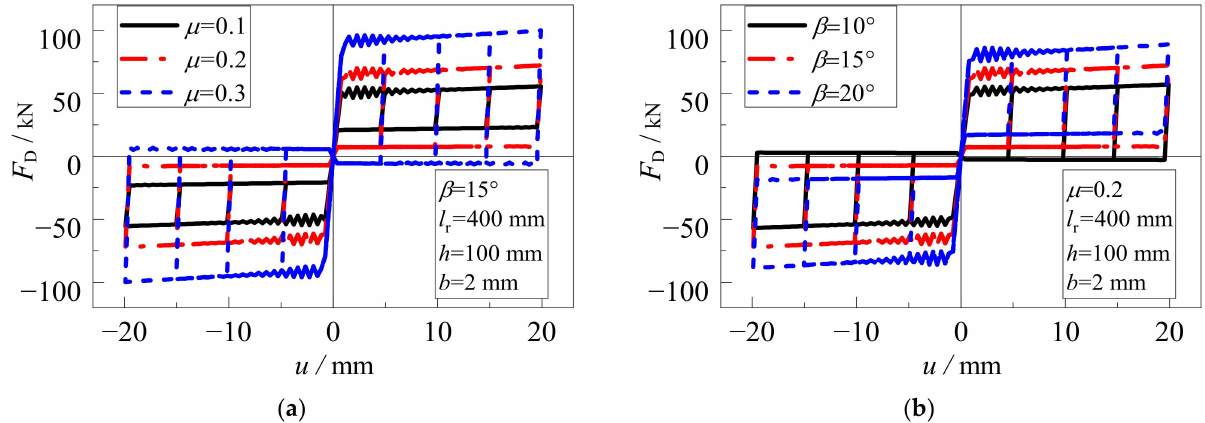
Figure 11. Effects of µ and β on force-displacement relationship: ( a ) µ ; ( b ) β .